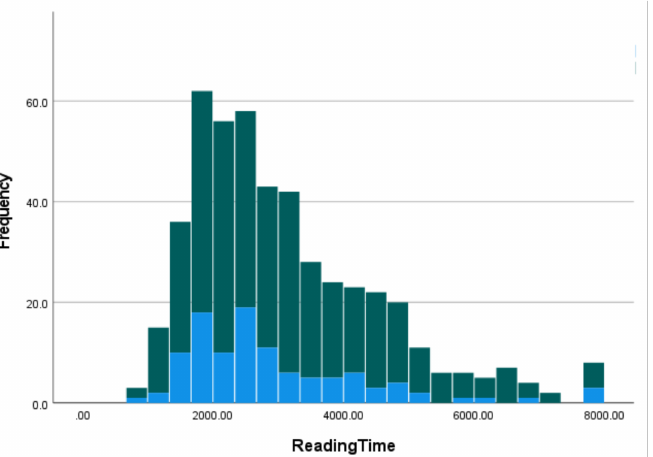
Figure 8. Stacked histogram showing reading times for correct trials (green) and incorrect trials